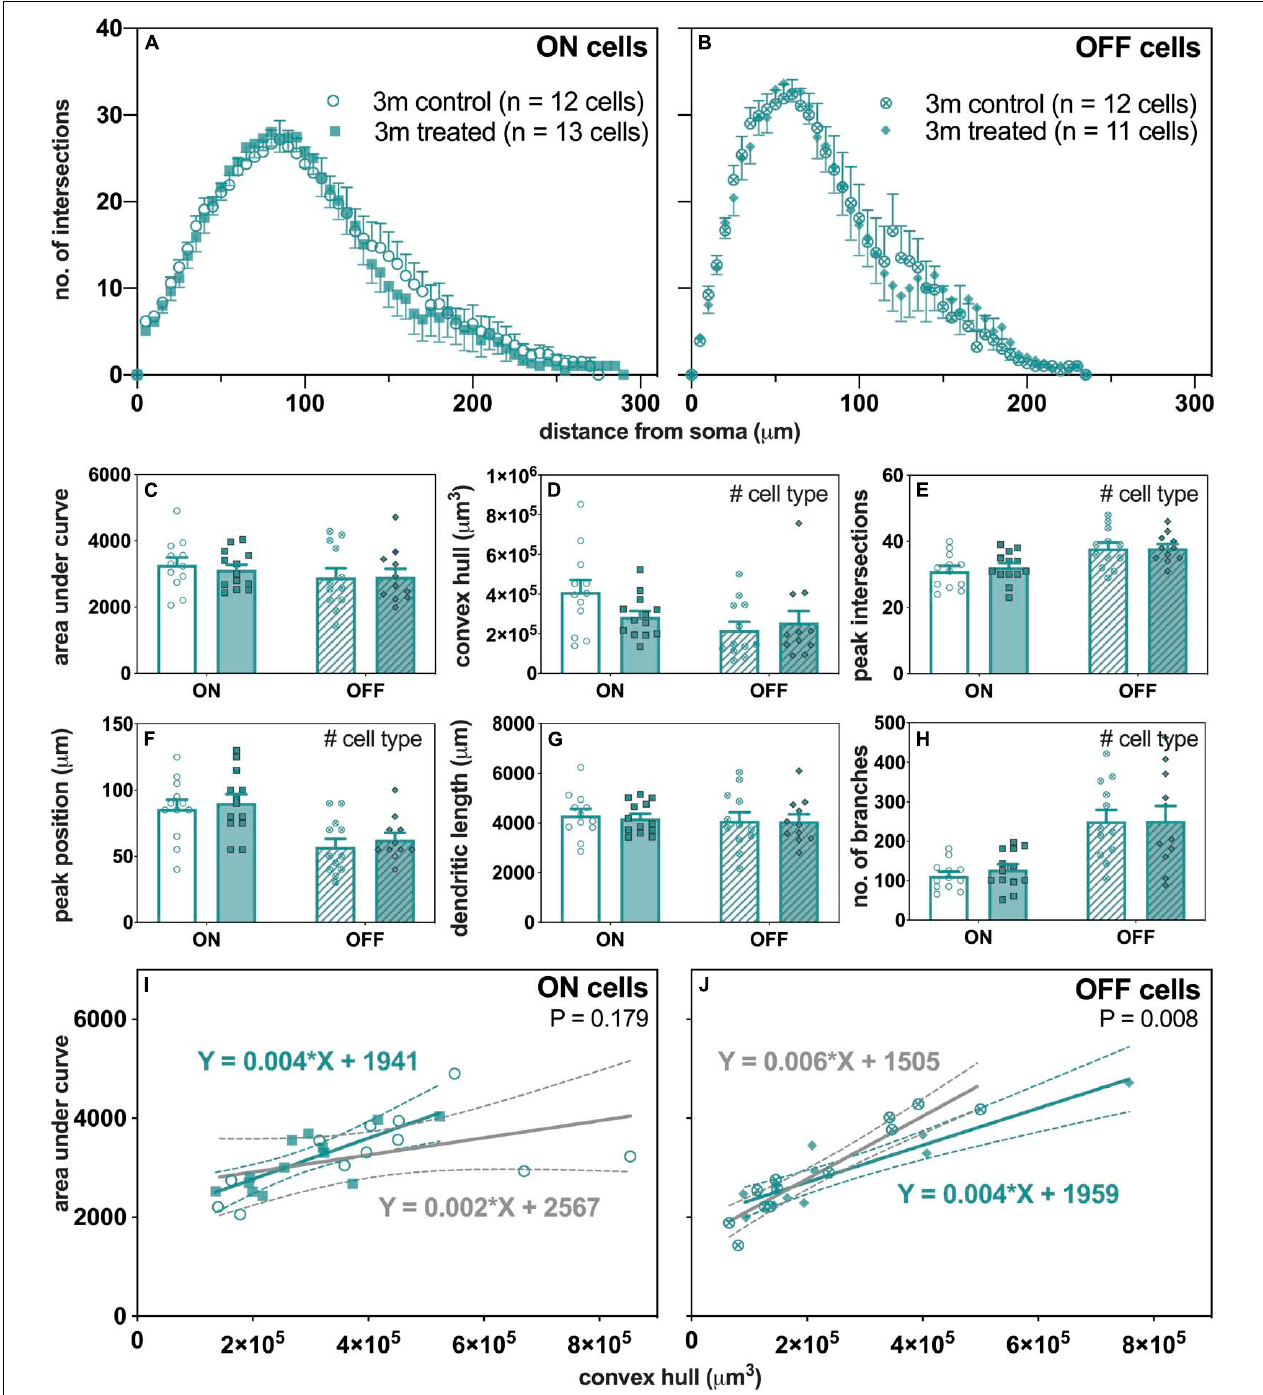
FIGURE 6 | Morphological assessment of ON and OFF RGCs in 3-month-old control and IOP-treated eyes 7 days after IOP elevation. (A,B) Sholl profiles displaying group averaged dendritic complexity (no. of intersections) relative to distance from soma in (A) ON [control, unfilled circles, n = 12 cells (4 animals); treated, filled squares, n = 13 cells (4 animals) and (B) OFF [control, crossed circles, n = 12 cells (4 animals); treated, filled diamonds, n = 11 cells (4 animals)] RGCs. (C) Area under curve for control (unfilled bars) and IOP-treated (filled bars) of ON (solid bars) and OFF (patterned bars) RGCs. (D) Convex hull volume (# p = 0.021). (E) Peak number of intersections (# p < 0.001). (F) Peak position (# p < 0.001). (G) Total dendritic length. (H) Total number of branches (# p < 0.001). (I,J) Dendritic complexity (area under curve) with respect to cell size (convex hull volume) in (I) ON and (J) OFF RGCs. Error bars, SEM; #, mixed effects model p < 0.05; solid line, linear regression; dashed line, 95% confidence interval; p -value, statistical significance of difference in